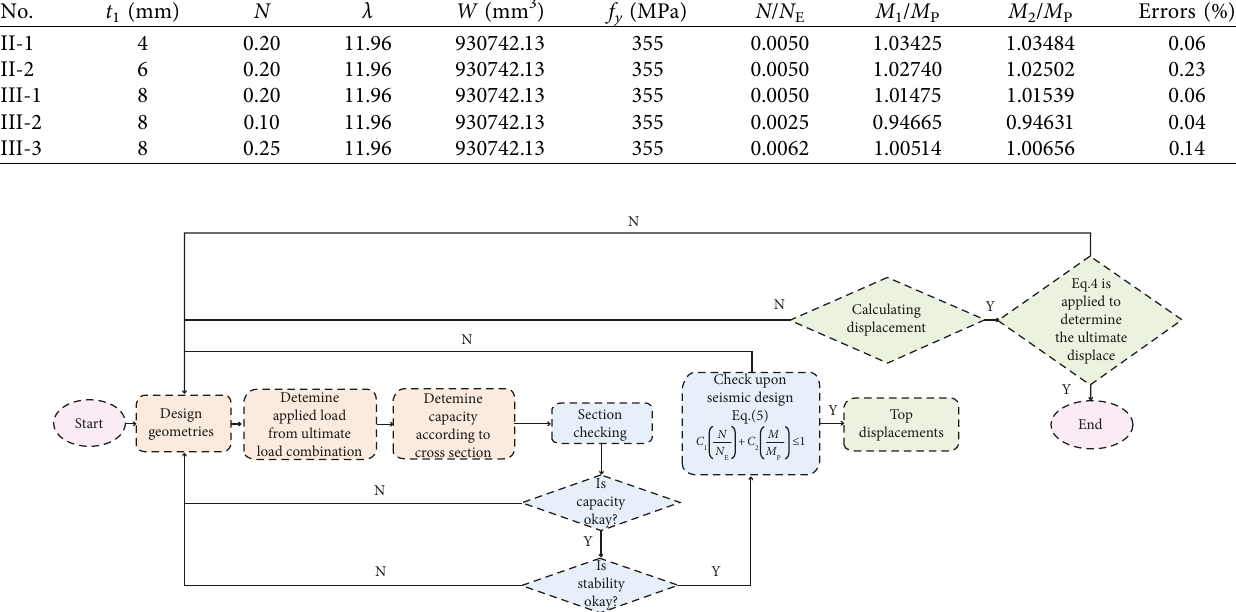
Figure 18: The design flow